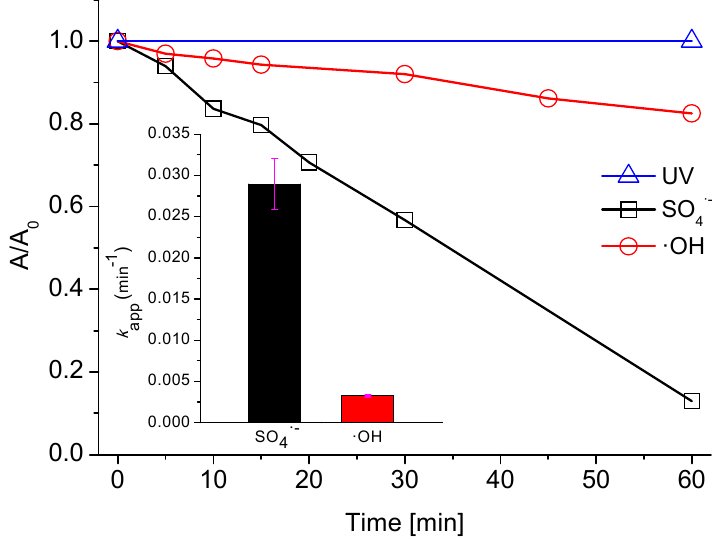
Figure 1. Decolorization (absorbance at 595 nm) of AB129 with SO 4• − , • OH and ultraviolet (UV) radiation alone (conditions: 25 mg/L AB129, 2.5 mM PDS, 10 mM H 2 O 2 , UV 150 W). The inset